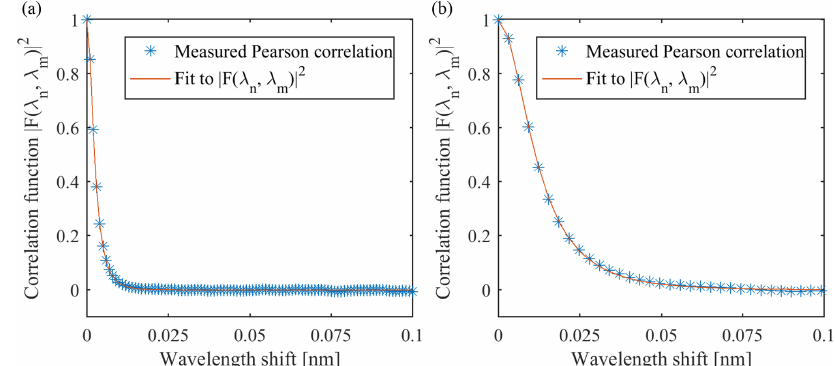
Figure 4. Measurement of the correlation function | F (λ n ,λ m ) | 2 in (a) the NIR (776nm) and (b) the SWIR band (1571nm). Blue stars denote the measured Pearson correlations between speckle patterns I n (λ n ) and I m (λ m ) . All wavelength shift combinations up to 0.1nm are averaged for 120 images. Error bars are omitted because the standard error of the mean value is too small to be displayed. The red graph denotes the fit of the measured data points to Eq. (10), with (a) l t = ( 59 . 3 ± 0 . 4 ) µm and (b) l t = ( 67 . 8 ± 0 . 5 ) µm. Table 2. Comparison SFA results of the measurement chain with the prediction model. Measurement uncertainties are given in the 1 σ interval. Type M polarization M spectral M detector SFA (%) Measurement NIR